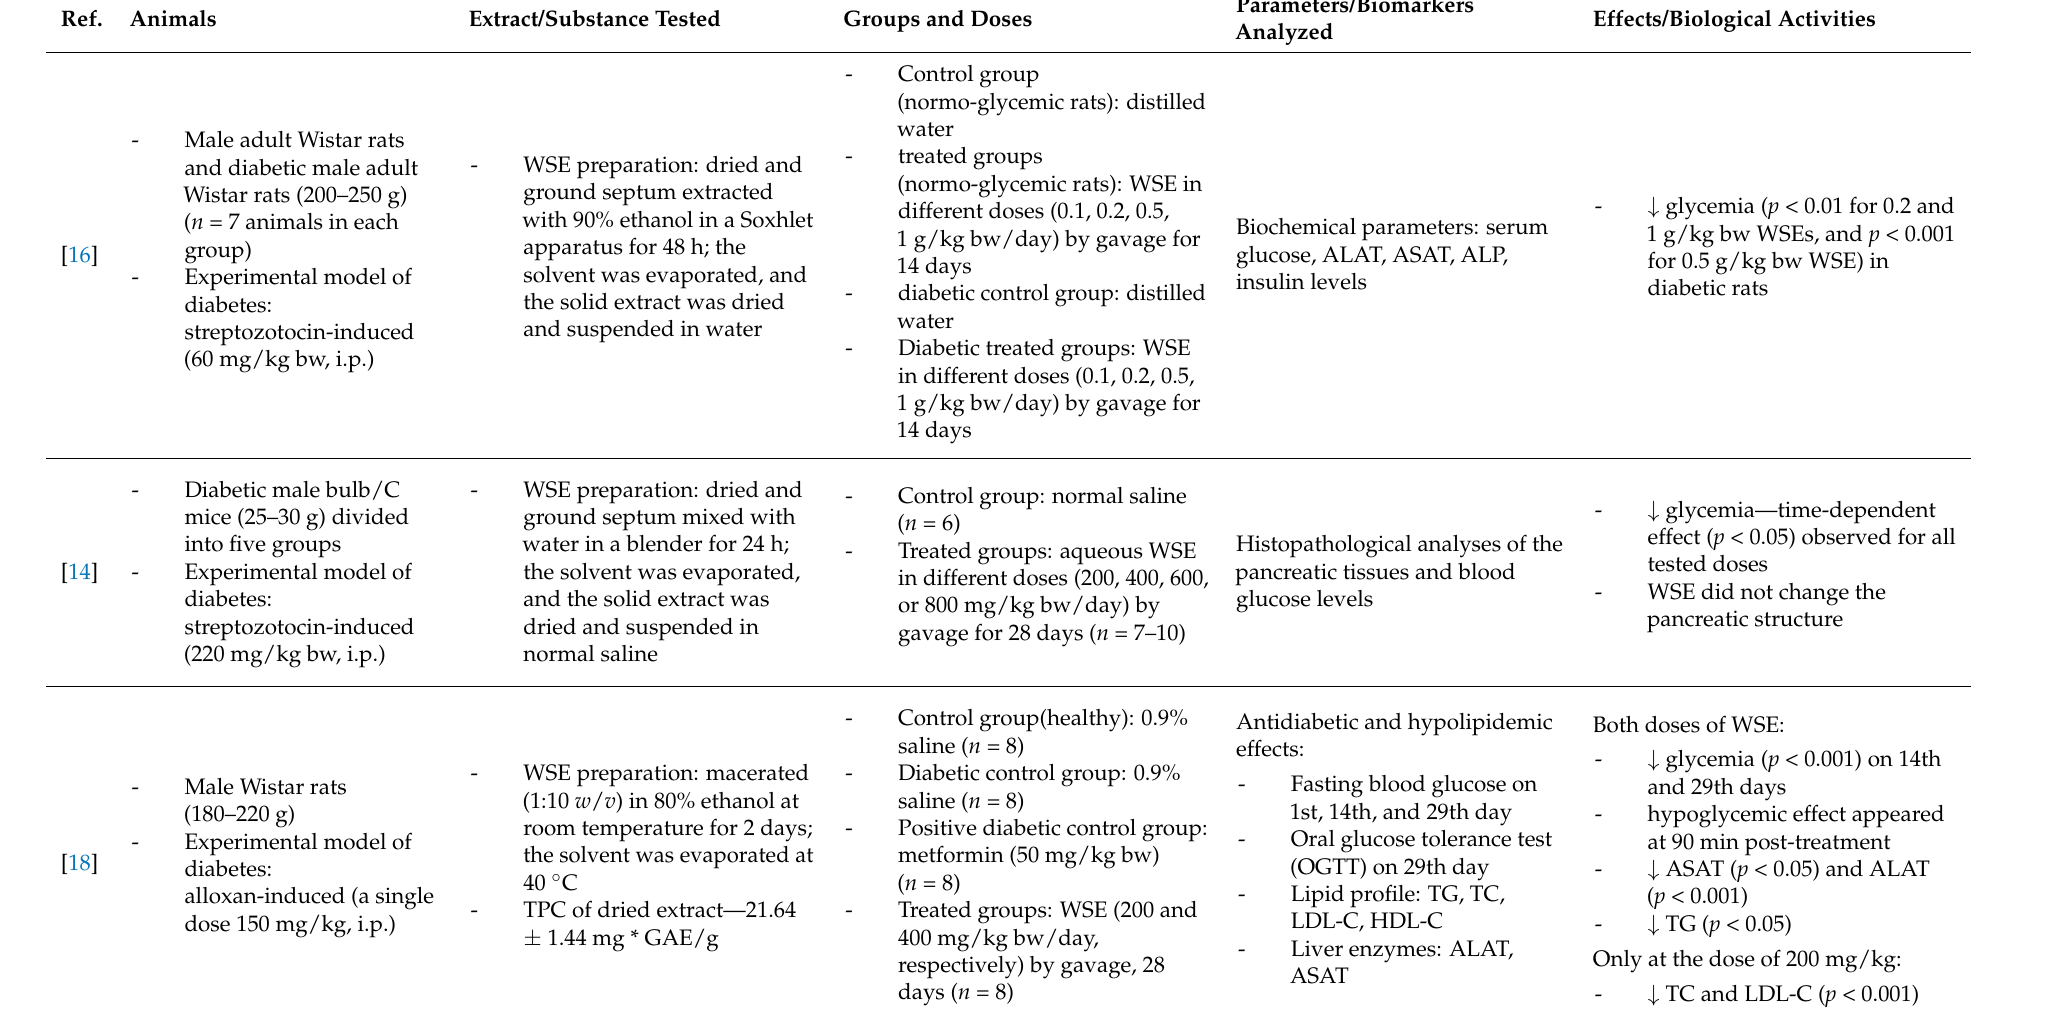
Table 6. Biological activities reported on in vivo studies performed with walnut septum extracts or compounds isolated from walnut septum.